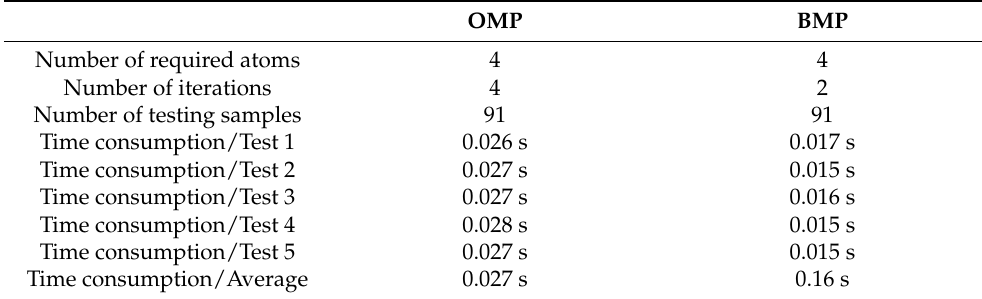
Table 9. Time consumption comparison based on fault diagnosis of driving gear in